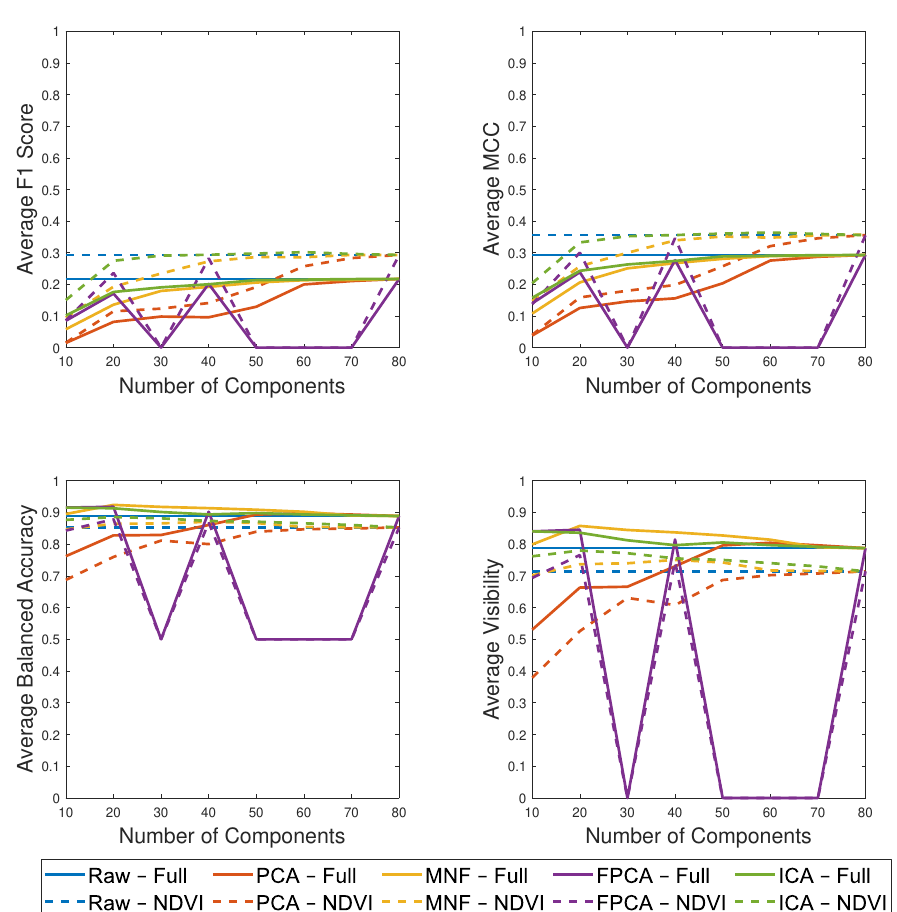
Figure 15. Performance measures using the ACE TD algorithm and each DR scheme with a varying number of retained components on the UDRC Selene